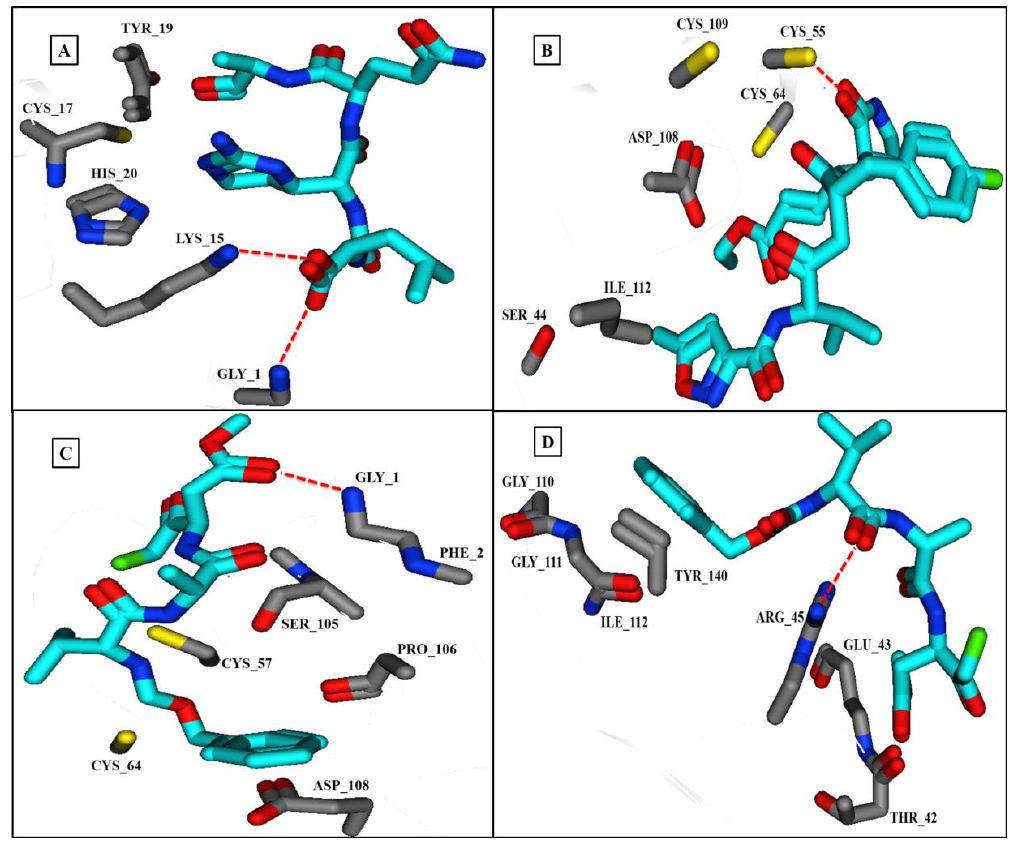
Figure 6. Best docked confirmations of PV2A pr ° with four inhibitors. Dotted lines show hydrogen bonding and poses between the PV2A pr ° and four inhibitors and the amino acid residues